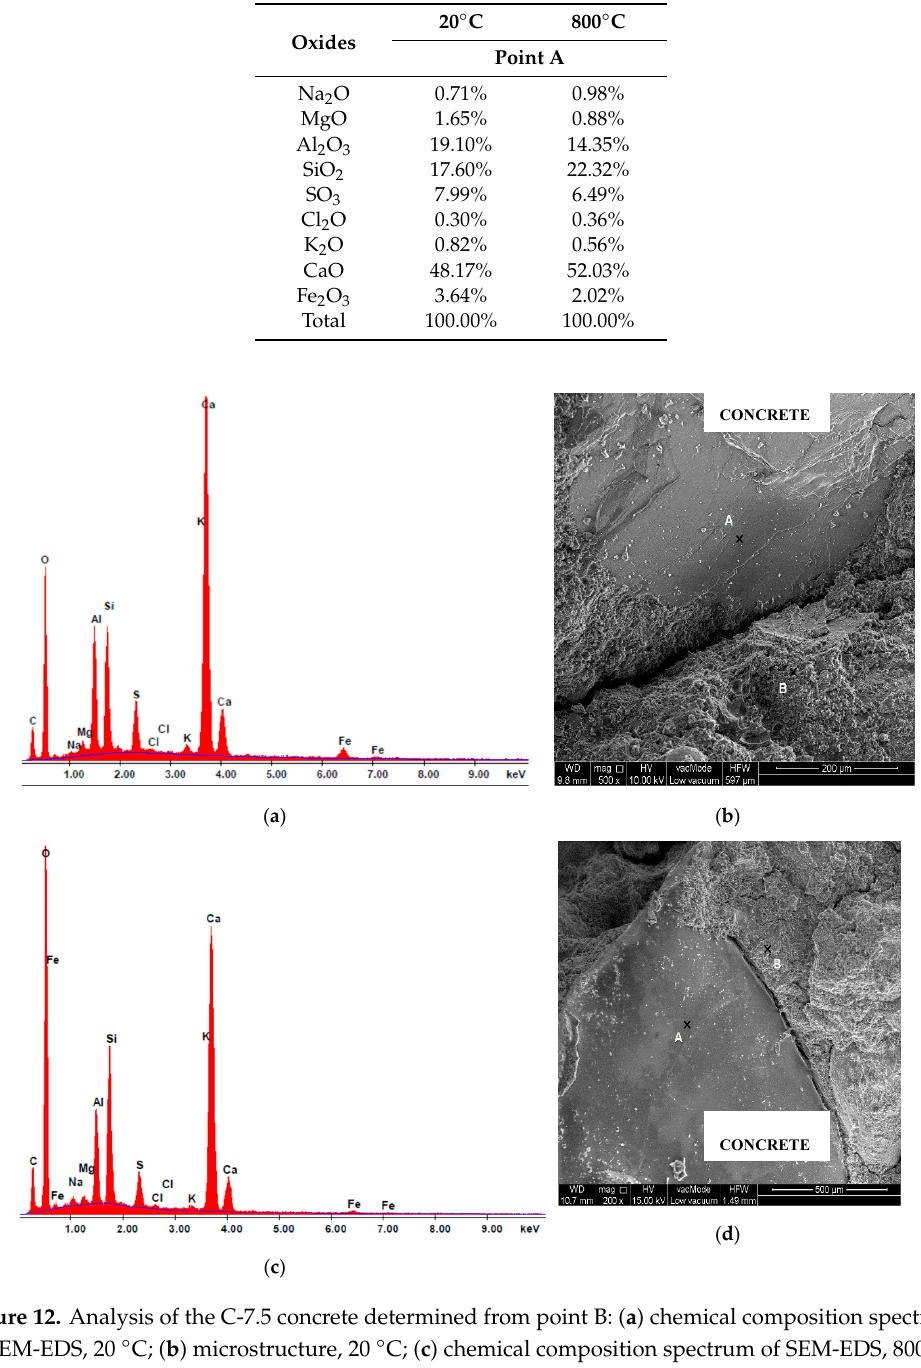
Table 12. Oxide composition of C-7.5 concrete with addition of heat-resistant glass determined from point A, weight %.